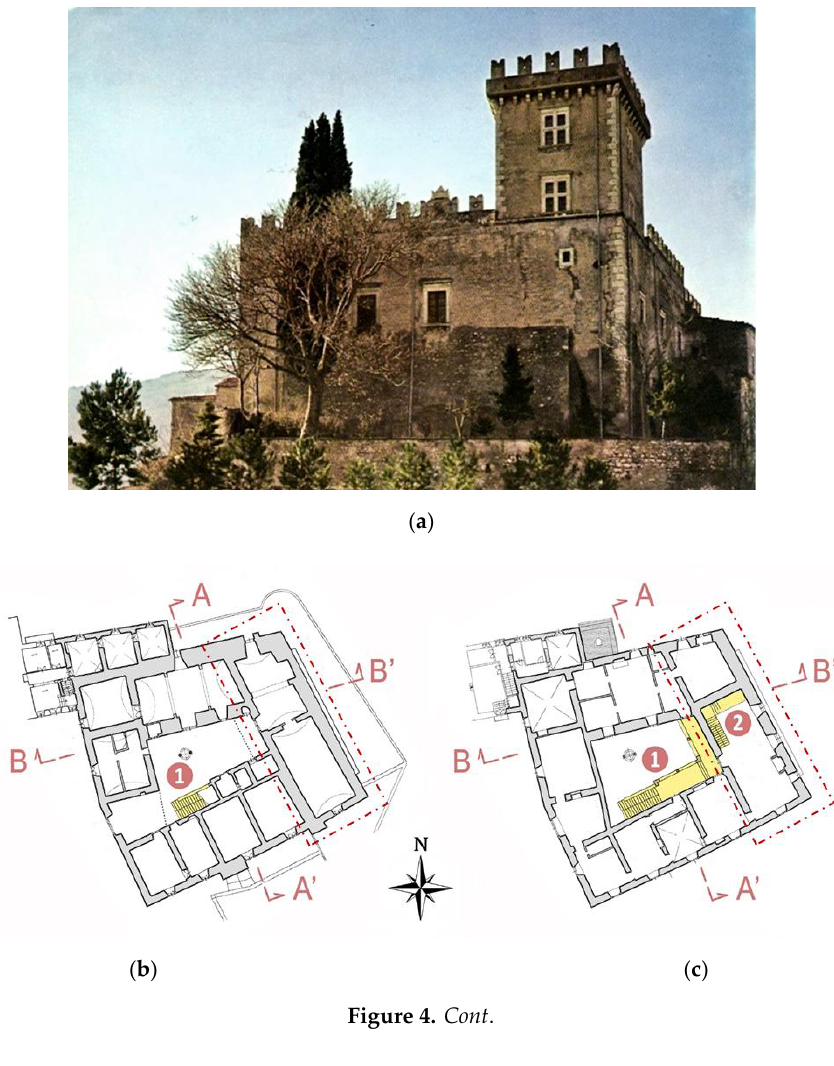
Figure 3. A view of the castle building at the beginning of the 20th century. Ruins of the tower in red circle: ( a ) exterior view; ( b ) view from the stairway and the lodge; (photo courtesy of the Municipal Historical Archive of Bussi).